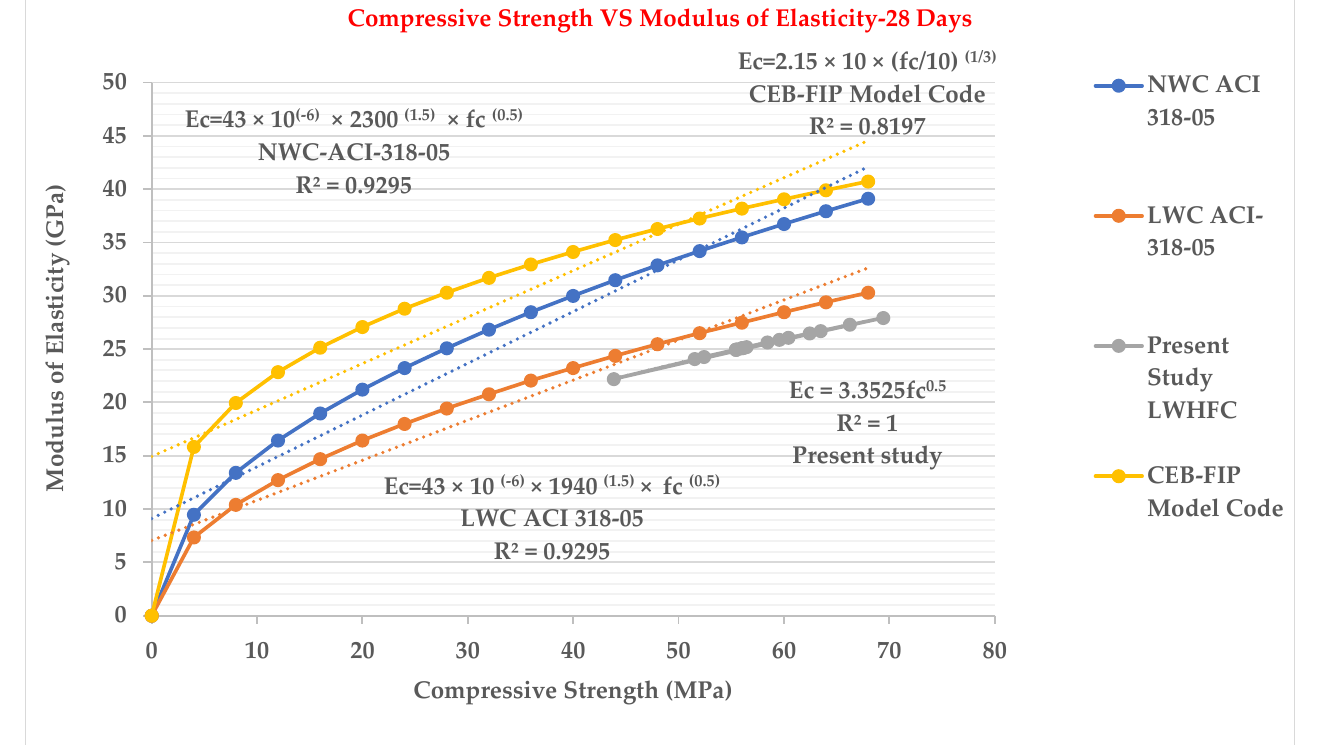
Figure 8. Relation between compressive strength and modulus of elasticity.